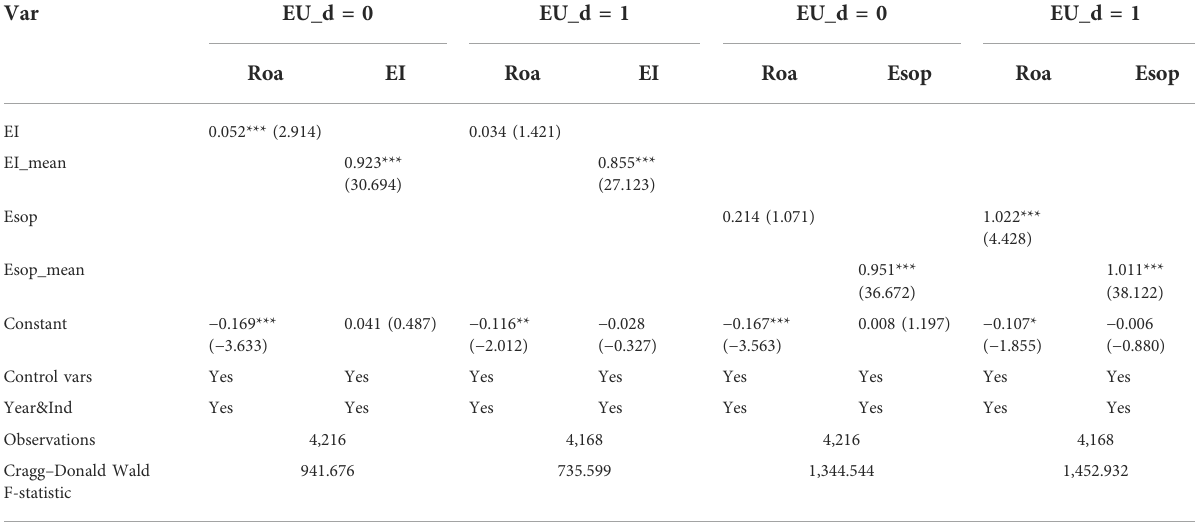
TABLE 9 Instrumental variables of models (2) – (3)